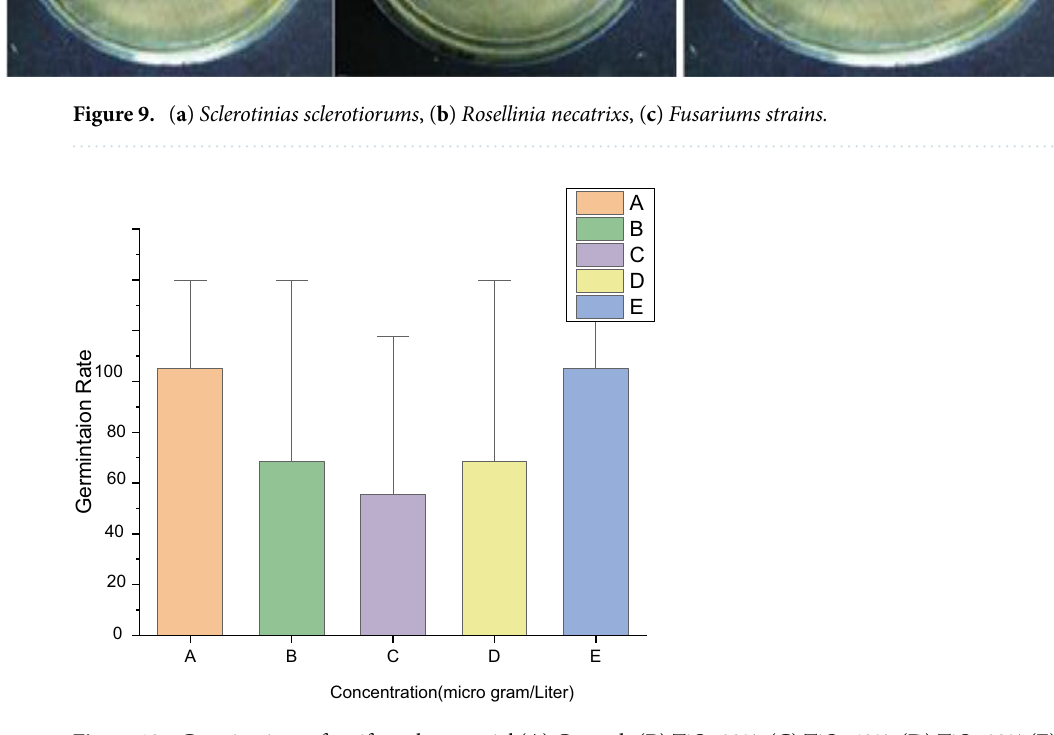
Figure 10. Germinations of antifungals potential ( A ) Controls ( B ) TiO 2 20%, ( C ) TiO 2 40%, ( D ) TiO 2 80% ( E )